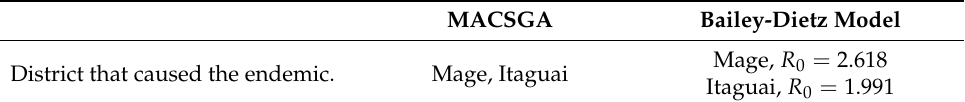
Table 4. Comparison of obtained computed results using MACSGA against published results by Iggidr et al. [30].